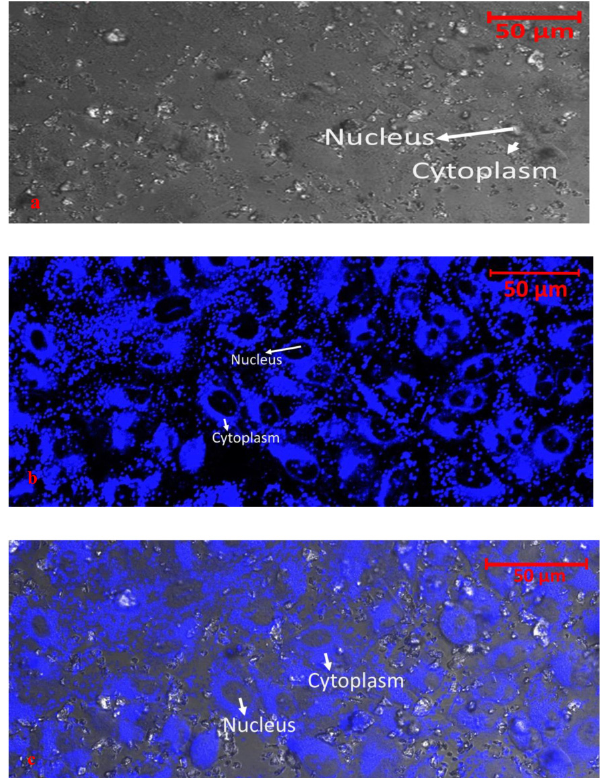
Figure 17. Confocal fluorescence images of MCF-7 cells stained with 20b . ( a ) Bright field image, ( b ) fluorescence image, and ( c ) merged image. Adapted from [48].